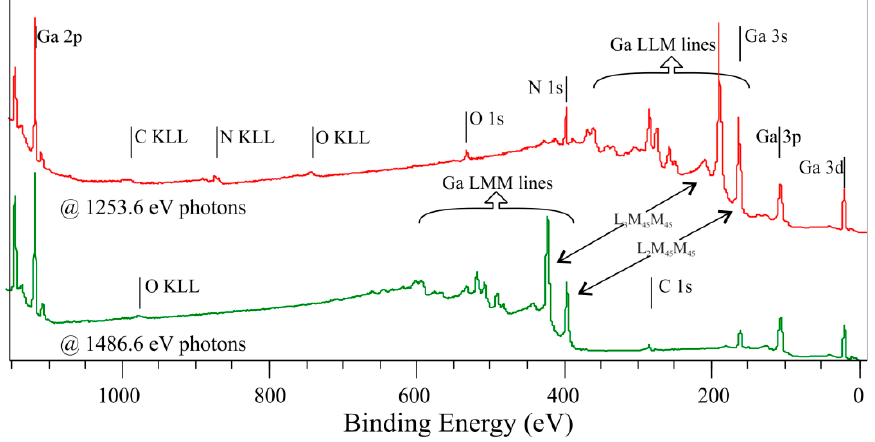
Figure 2. Survey spectra for a nondoped GaN(0001) surface, collected with different photon ener ‐ gies.